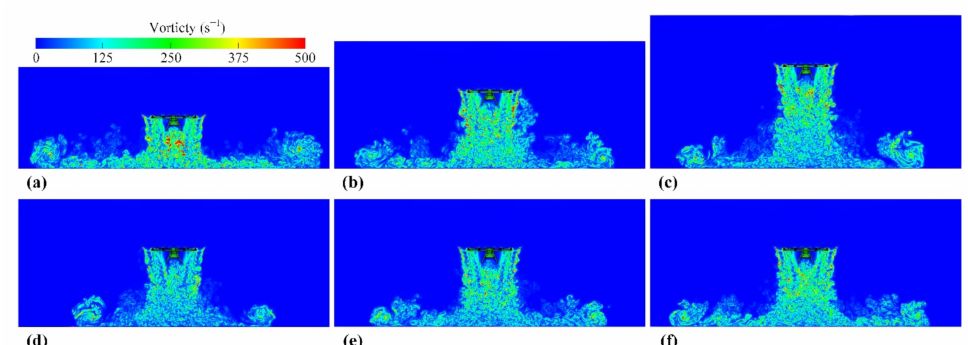
Figure 12. Vorticity distribution diagram of downwash airflow in hovering with front view ( t = 1.3 s). ( a ) F A = 2 m, L G = 16 kg; ( b ) F A = 3 m, L G = 16 kg; ( c ) F A = 4 m, L G = 16 kg; ( d ) F A = 3 m, L G = 4 kg; ( e ) F A = 3 m, L G = 8 kg; ( f ) F A = 3 m, L G = 12 kg. The plane of the front view is profile A-A, as shown in Figure A1a.